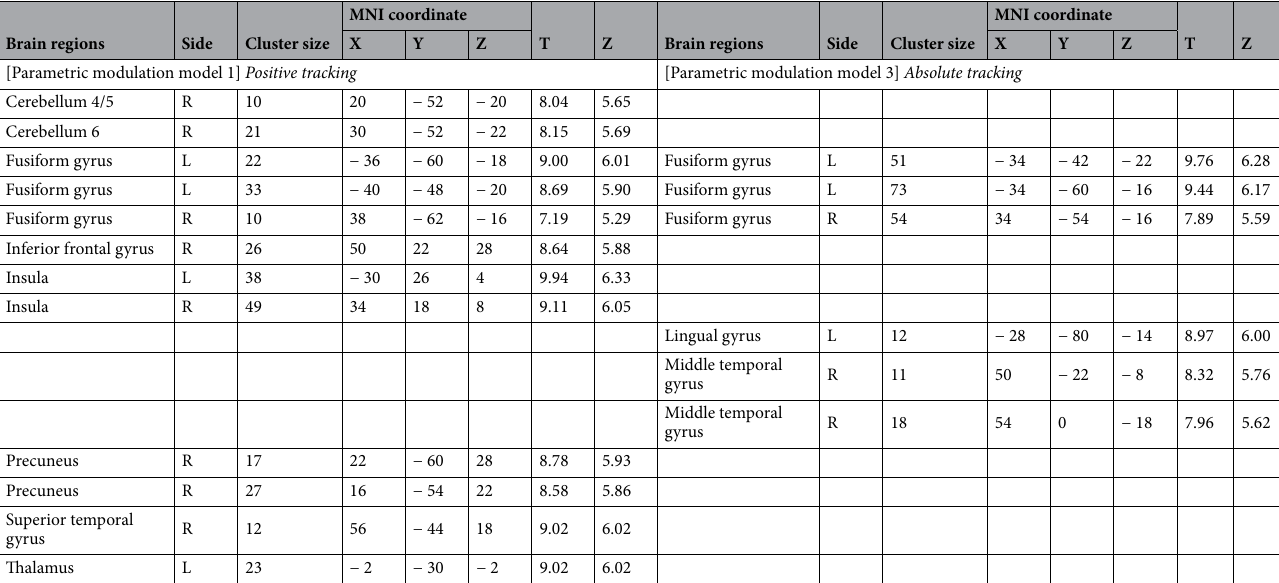
Table 4. MNI coordinates of results for parametric modulation model 1 and 3. There was no significantly activated regions in parametric modulation 2 ( Negative tracking ). Row orders was sorted in alphabetical order with a few vacant rows to maximally visualize difference of two contrast